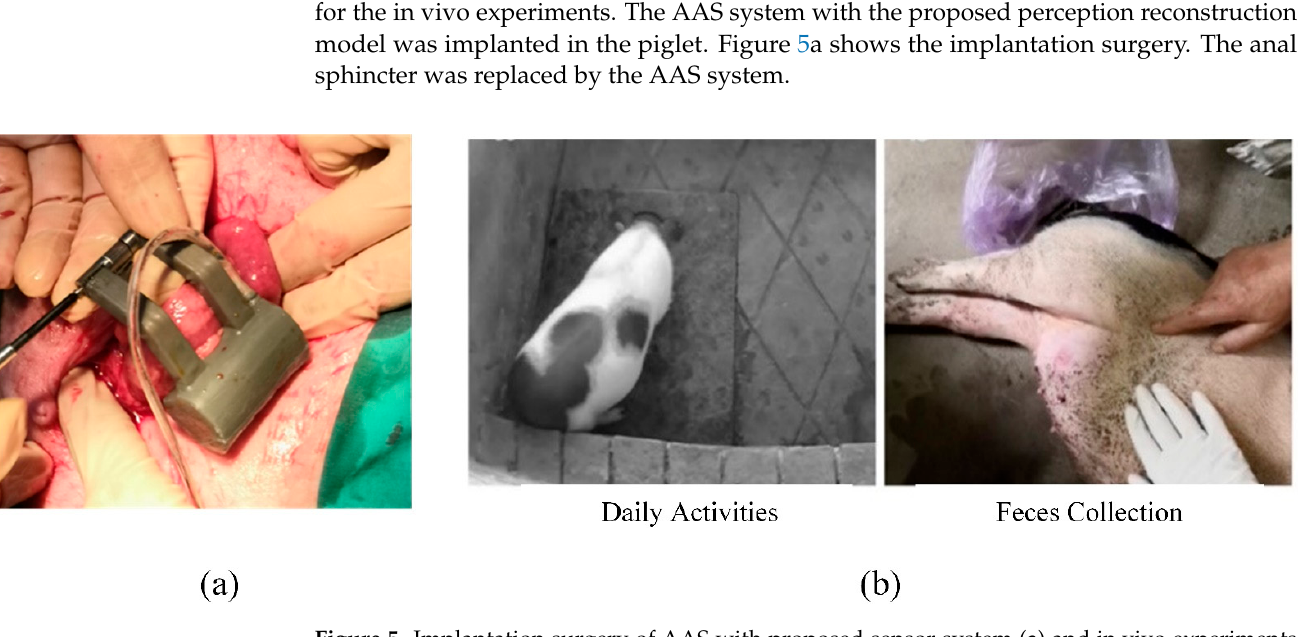
Figure 5. Implantation surgery of AAS with proposed sensor system ( a ) and in vivo experiments observation ( b ).